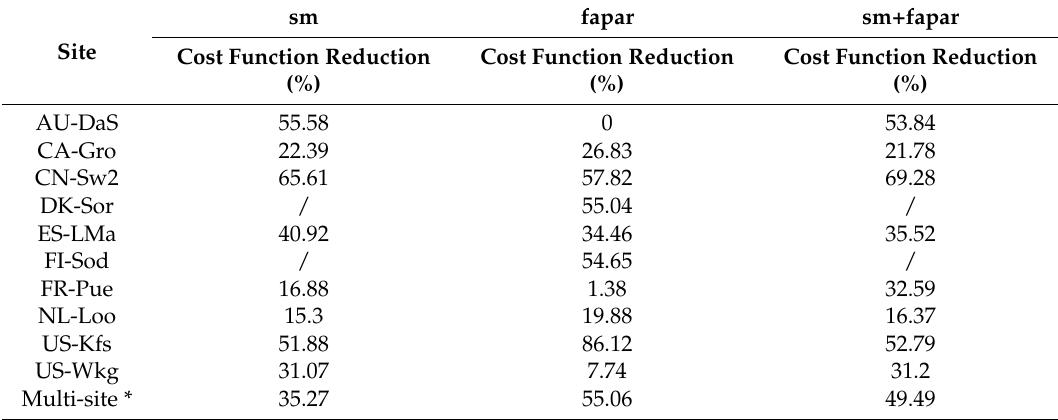
Table 2. Summary of optimization results on cost function and gradient reduction for different denotes simultaneous assimilation soil moisture and